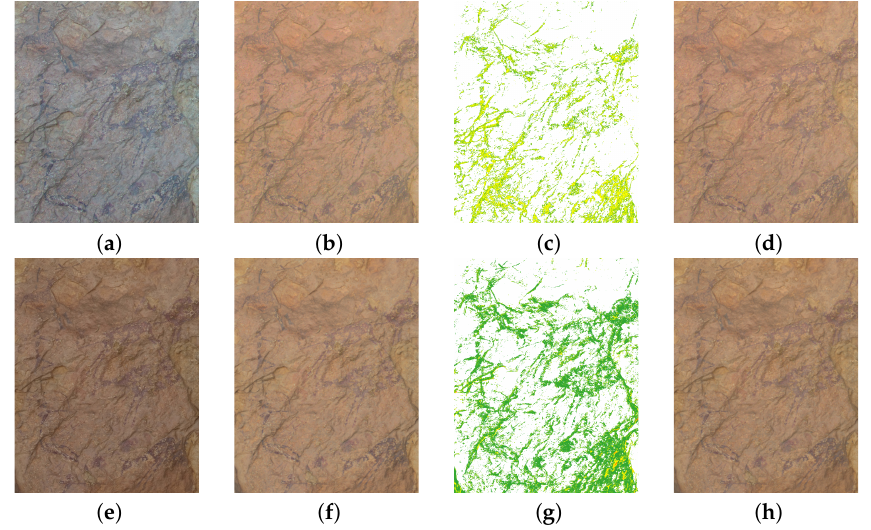
Figure 11. Wounded animal images: ( a – d ) Sigma SD15; ( e – h ) Fujifilm IS PRO; ( a , e ) Original image; ( b , f ) GP characterized image; ( c , g ) ∆ E ∗ comparative image; ( d , h ) Second-order characterized image. ab